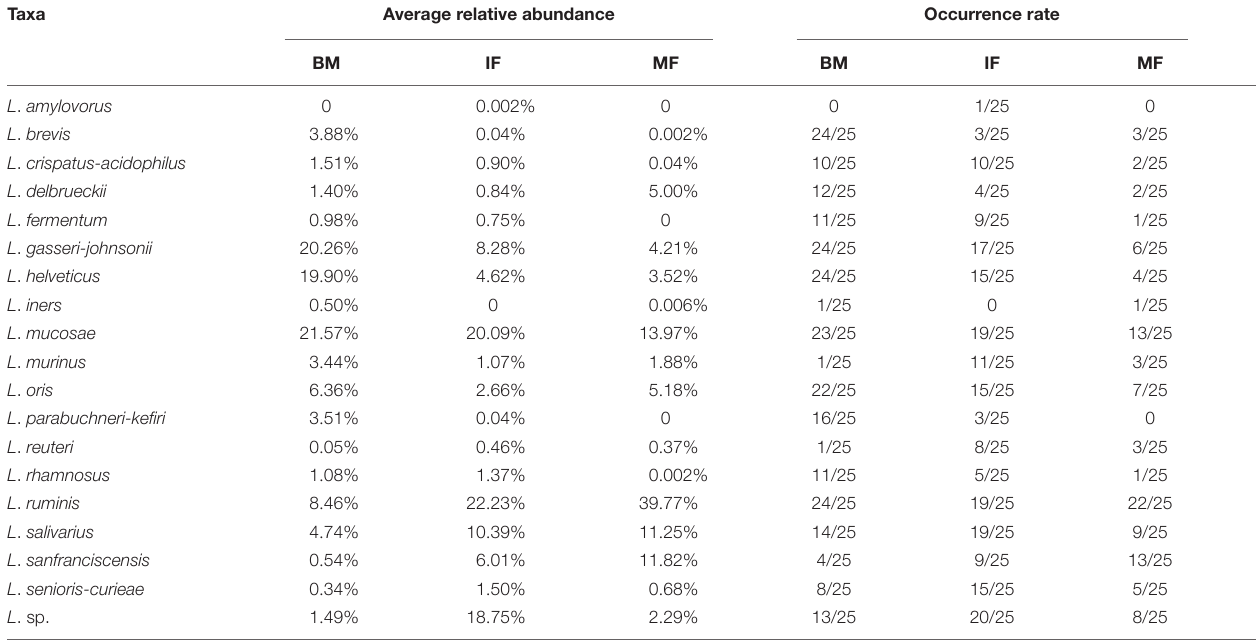
TABLE 3 | Average relative abundance and occurrence rate of Lactobacillus at the species level among breast milk (BM, n = 25), maternal feces (MF, n = 25), and infant feces (IF, n = 25). Taxa Average relative abundance Occurrence